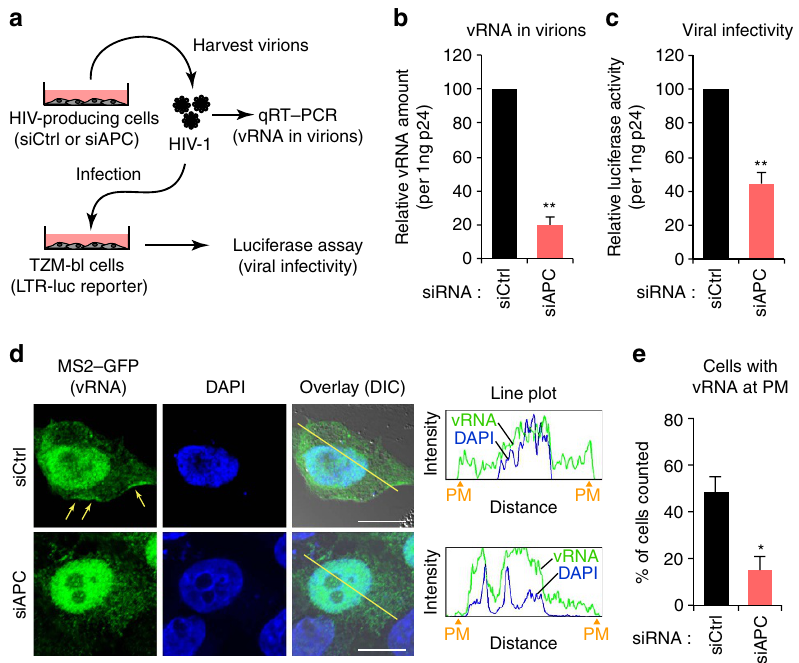
Figure 6 | APC regulates the PM localization and viral packaging of HIV-1 vRNA. ( a ) Schematic representation of virions from HIV-producing cells. HEK293 cells were treated with either control siRNA (siCtrl) or APC-targeted siRNA mix (siAPC) for 24h before transfection with pNL4-3. After 48h, virus-containing supernatants were subjected to RNA extraction or used to infect TZM-bl reporter cells to measure vRNA levels or viral infectivity, respectively. ( b , c ) APC depletion reduces the level of vRNA in virions ( b ) and also suppresses viral infectivity ( c ). Data were normalized to p24 antigen levels in the supernatants. ( d , e ) HeLa cells were treated with either siCtrl or siAPC for 24h before co-transfection with pNL4-3-pol-MS2x24 and MS2–GFP expression plasmids. At 48h after transfection, cells were stained with anti-GFP and 4,6-diamidino-2-phenylindole (DAPI) ( d , left). Scale bar, 10 m m. The arrows indicate the localization of vRNA at the plasma membrane (PM). Line plots in the right panels in d indicate the fluorescence intensity with regions of the PM. The bar chart indicates the percentage of cells (at least 20 cells selected from random fields) that vRNA was found at the PM. All graphs are presented as a mean ± s.d. ( n ¼ 3). * P o 0.05, ** P o 0.01, two-tailed unpaired t